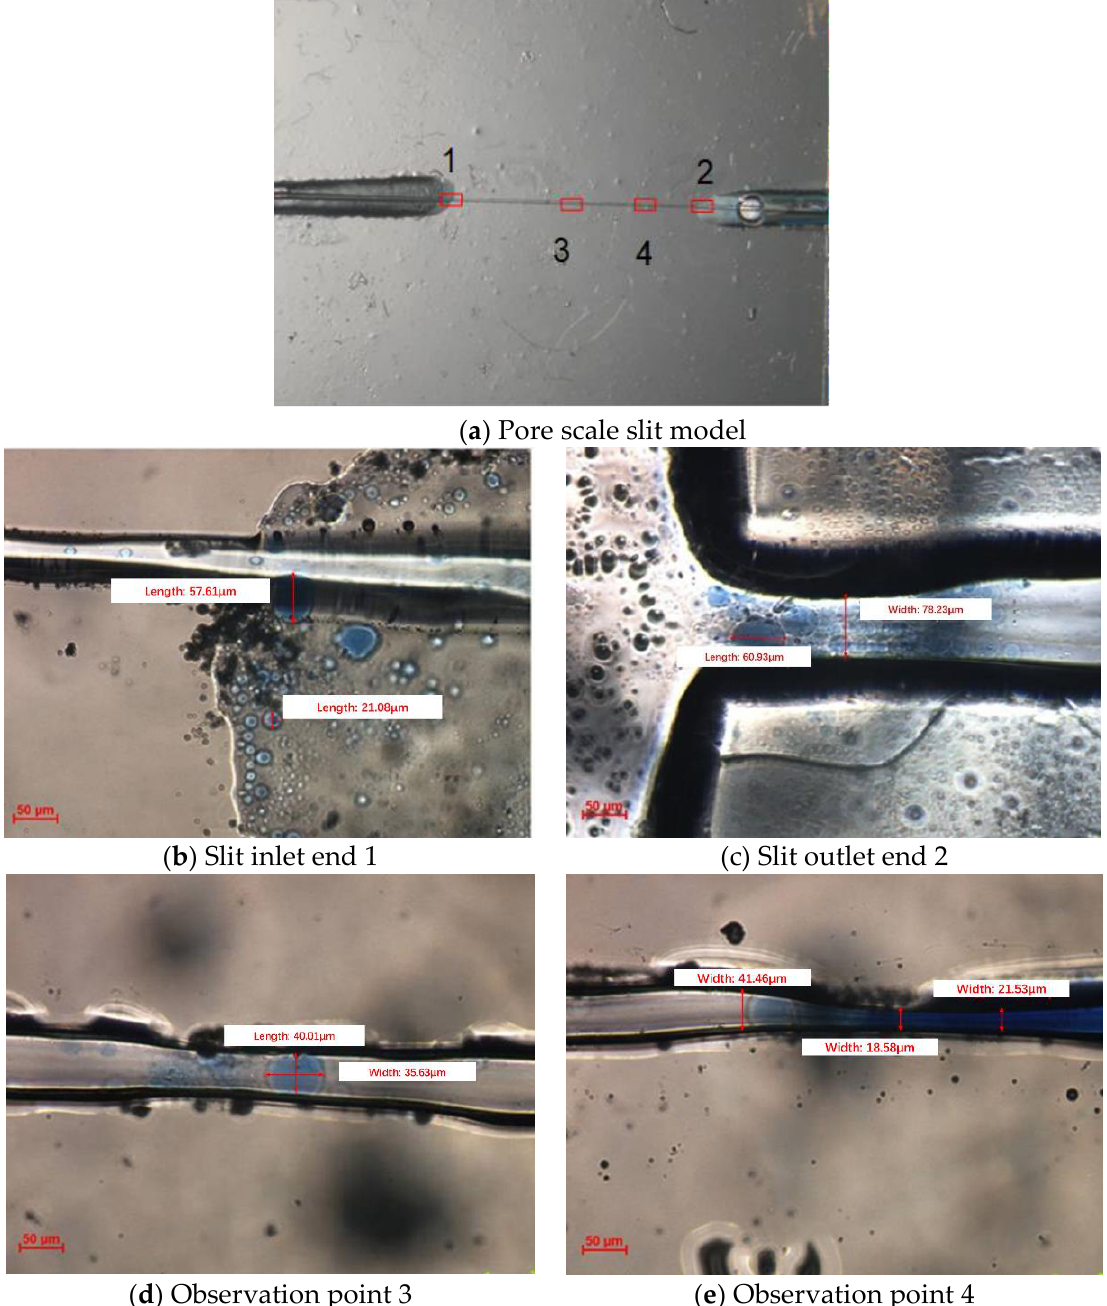
Figure 4. Photos of the microscopic experiment of pore scale slit